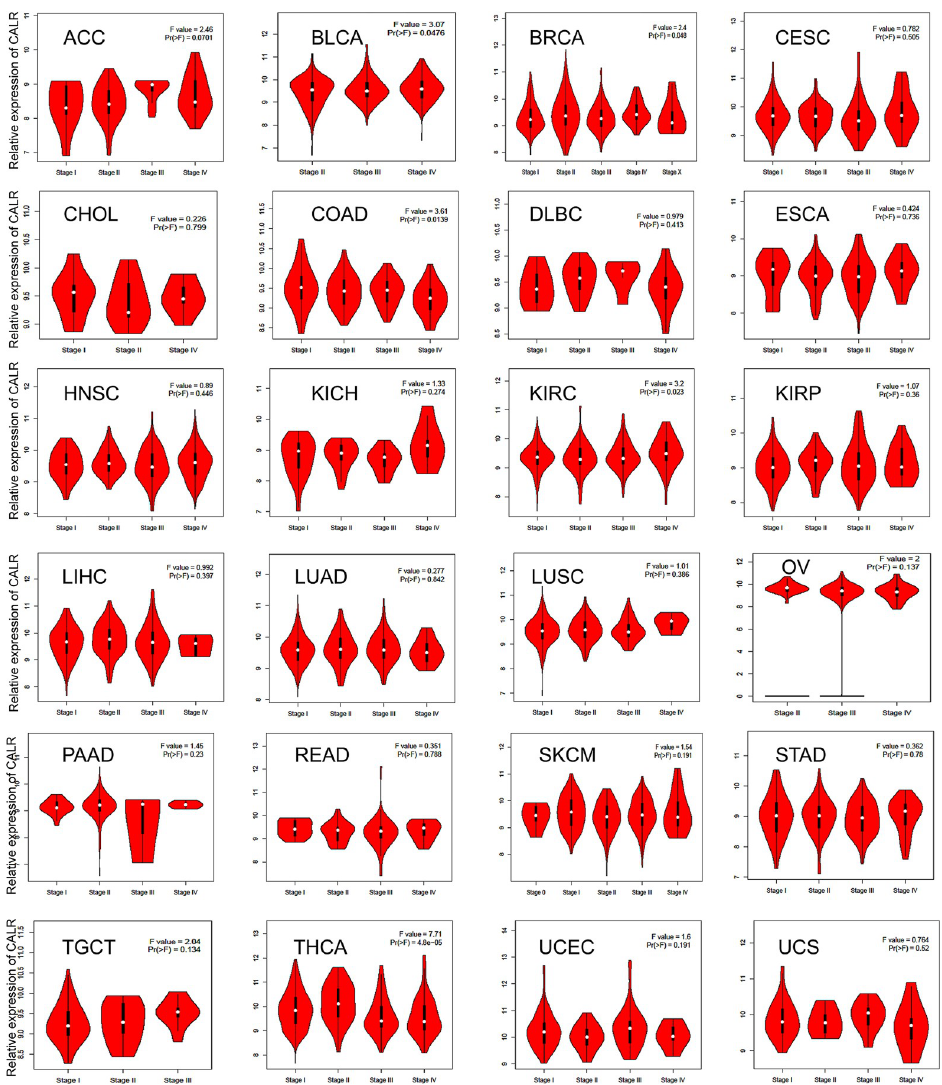
Fig 3. Correlation between CALR expression with pathological stages of tumors (GEPIA). Note: P value < 0.05 is considered statistically significant. https://doi.org/10.1371/journal.pone.0261254.g003 PLOS ONE | https://doi.org/10.1371/journal.pone.0261254 December15,